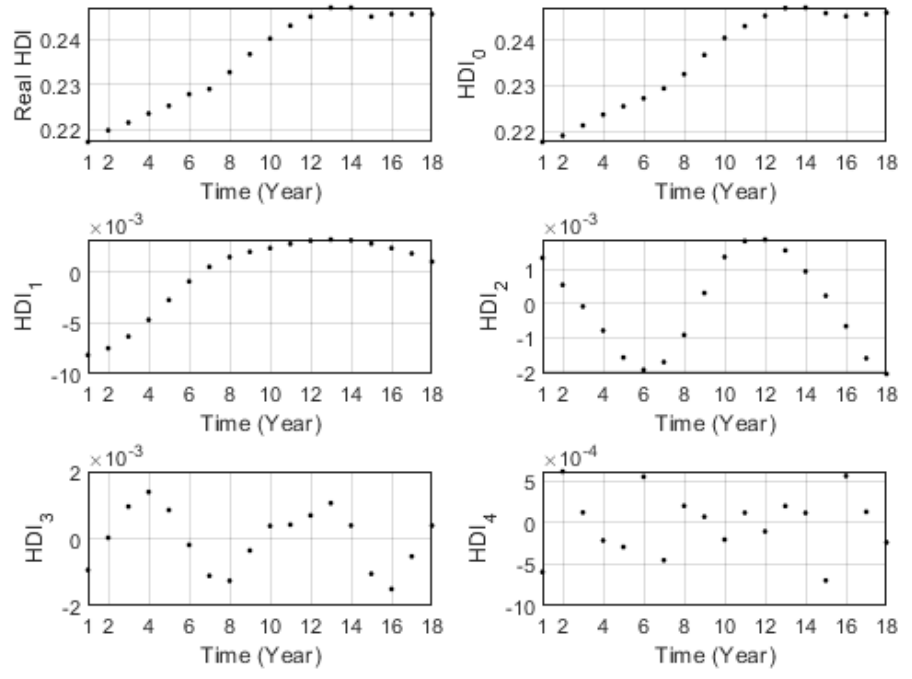
Figure 9. The plots of the HDI index, real and time scale model